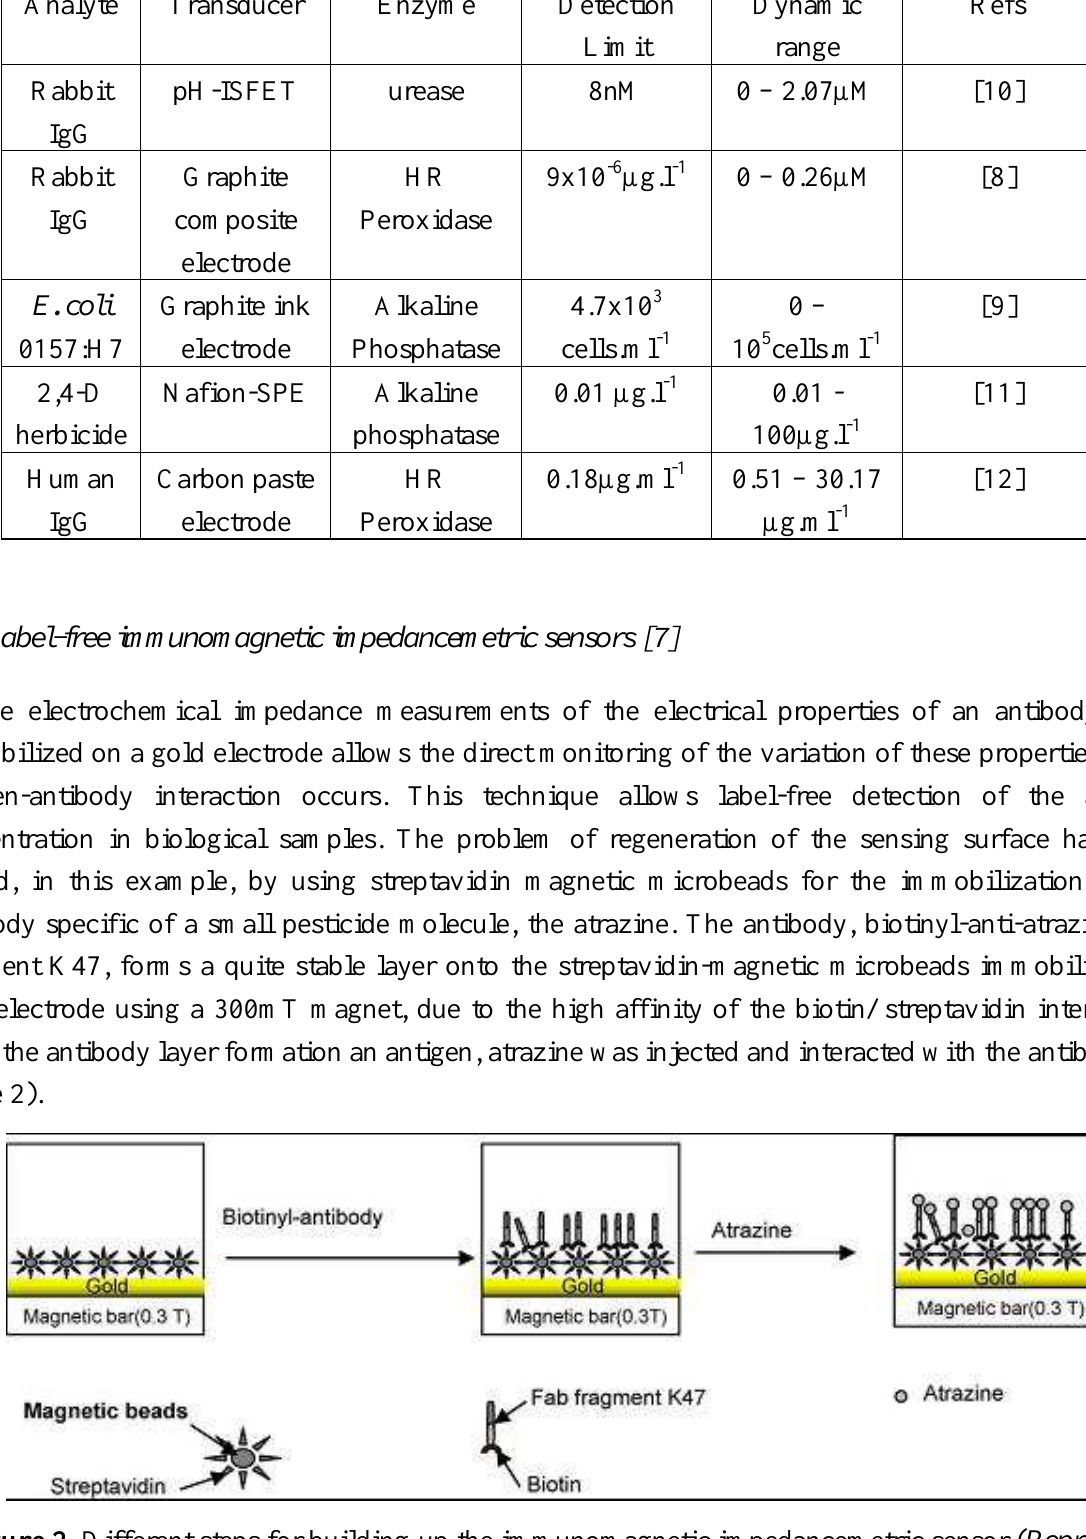
Figure 2. Different steps for building-up the immunomagnetic impedancemetric sensor ( Reprinted from [7] with permission from Elsevier